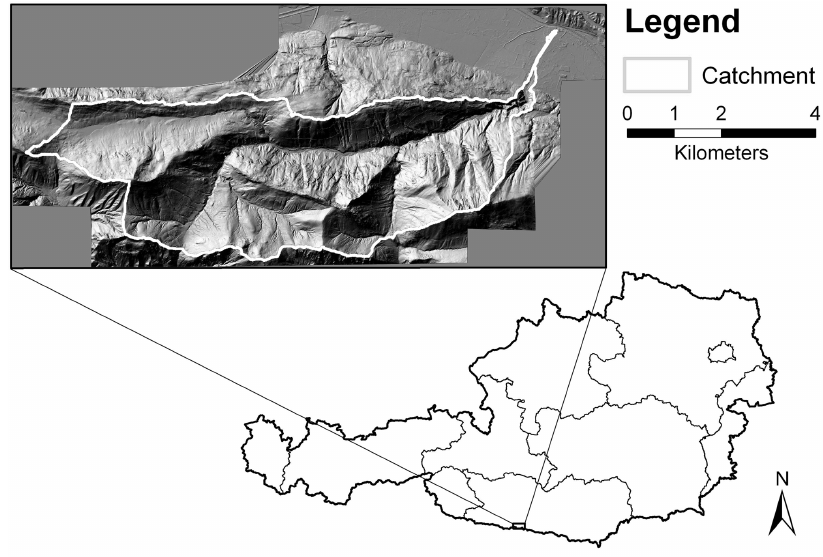
Fig. 1. Overview of the study catchment and its location in